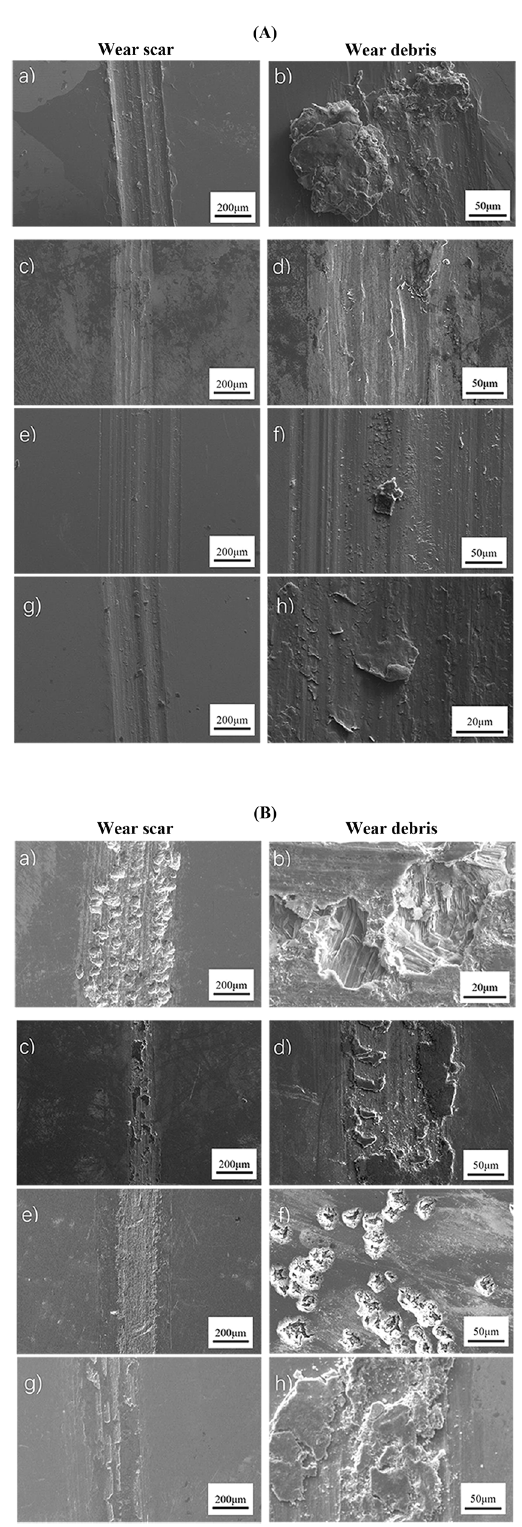
Fig. 3 A SEM micrograph of wear scar and wear debris of four samples under dry sliding condition: ( a ), ( b ) Pure Zn; ( c ), ( d ) Zn- 0.5Li; ( e ), ( f ) Zn-1Cu; ( g ), ( h ) Zn-1Ge; ( B ) SEM micrograph of wear scar and wear debris of four samples in Hank ’ s solution: ( a ), ( b ) Pure Zn; ( c ), ( d ) Zn-0.5Li; ( e ), ( f ) Zn-1Cu; ( g ), ( h )